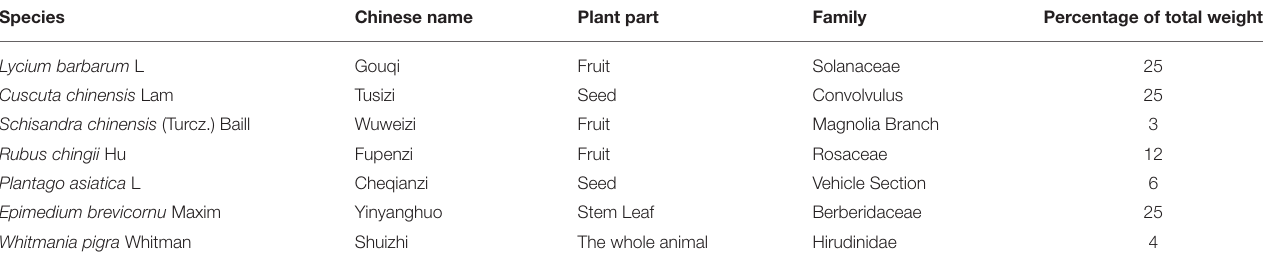
TABLE 1 | Composition of